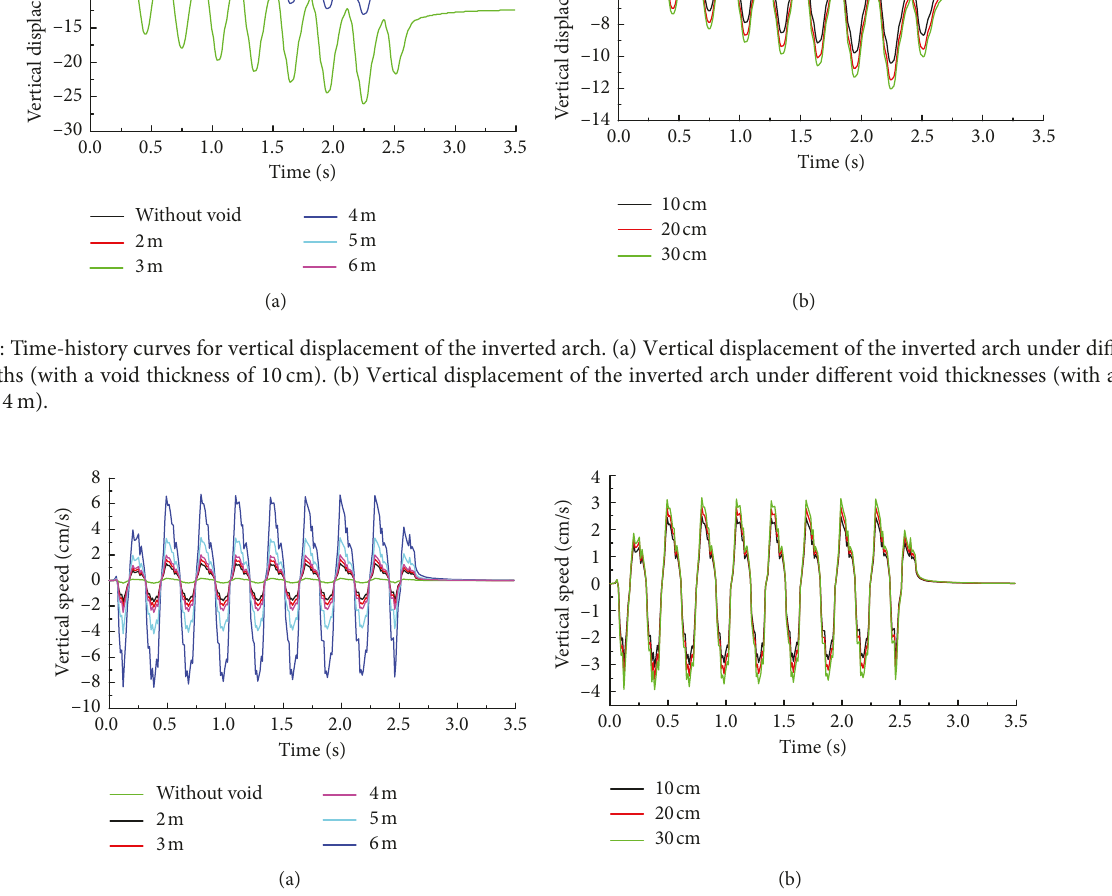
Figure 8: Time-history curves for vertical velocity of the inverted arch under different void cases. (a) Vertical velocity of the inverted arch under different void widths (with a void thickness of 10cm). (b) Vertical velocity of the inverted arch under different void thicknesses (with a void width of 4 m). Table 4: Peak values of vertical displacement and velocity of the inverted